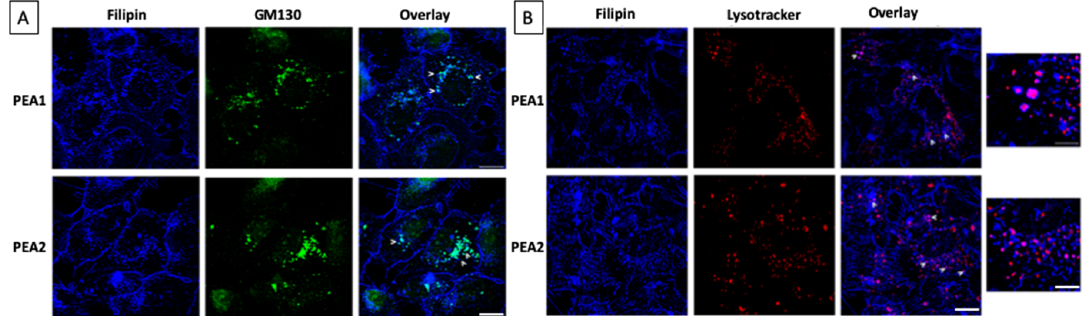
Figure 4. Analysis of cholesterol distribution in chemosensitive and chemoresistant cell lines. Representative images of double immunofluorescence assays. Specifically, PEA1 and PEA2 cells were stained with Filipin and the Golgi marker GM130 antibody ( a ) or the Lysostracker dye ( b ). Scale bar = 10 μm. Arrows indicate co-localization areas. In b, higher magnification pictures are shown, scale bar = 5 μm.